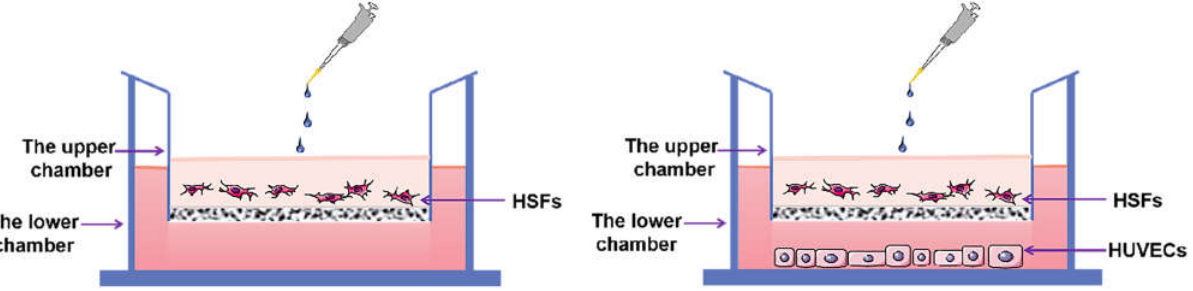
Figure 17. The HSFs-HVECs cell co-culture model. The picture on the left shows the control group with the proportion of HVECs being